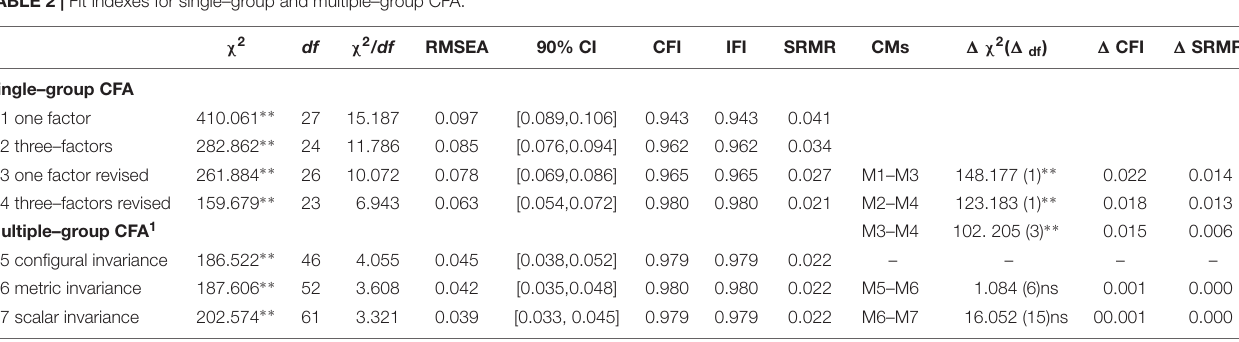
TABLE 2 | Fit indexes for single–group and multiple–group